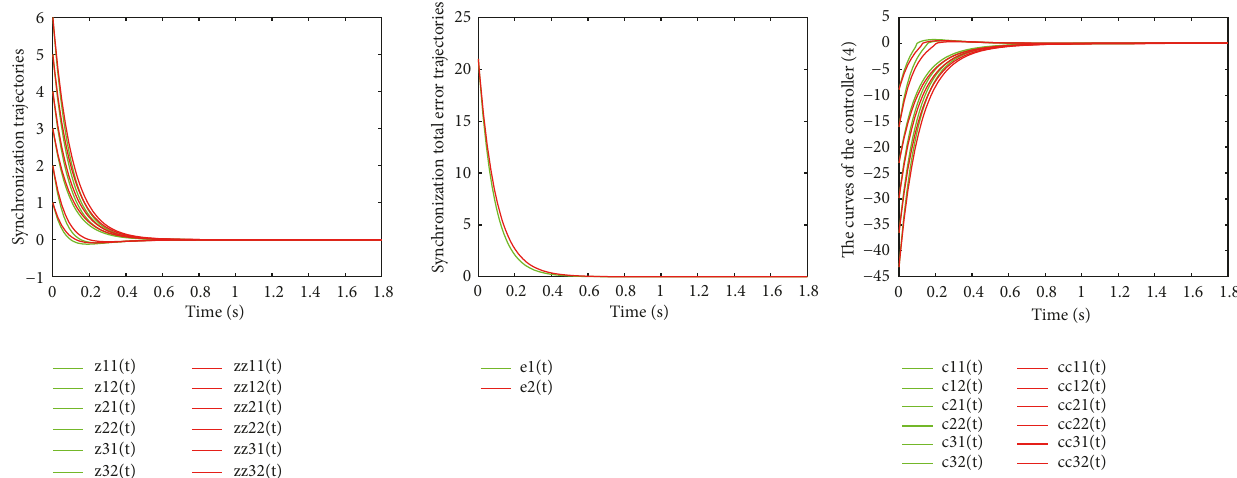
Figure 6: Synchronization trajectories, synchronization total error trajectories of networks (1) and (2) with controller (4) and the curves of controller (4) for Case I-2 of Example 28.